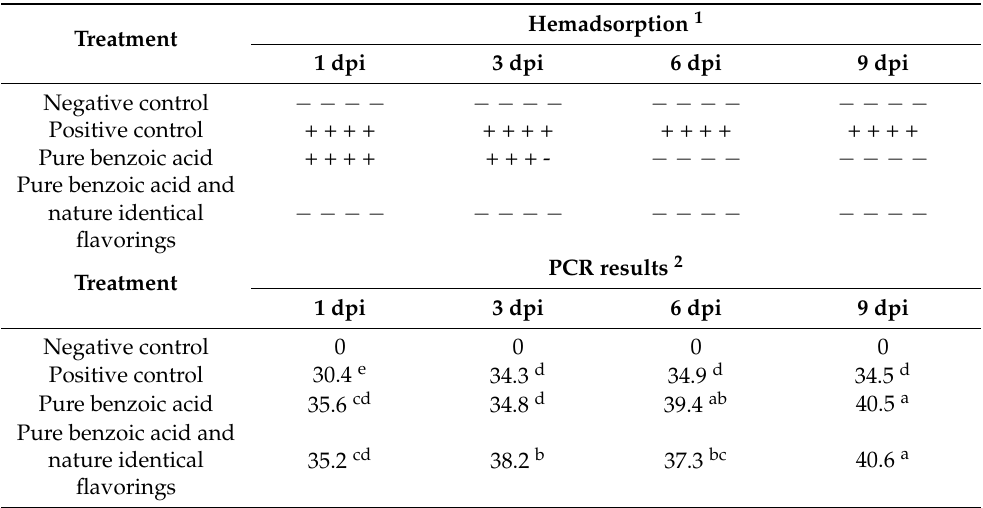
Table 4. Effect of pure benzoic acid and the combination of pure benzoic acid and nature identical flavorings on hemadsorption and detection of African swine fever (ASF) virus by real-time PCR at different days post inoculation (dpi) in the feed